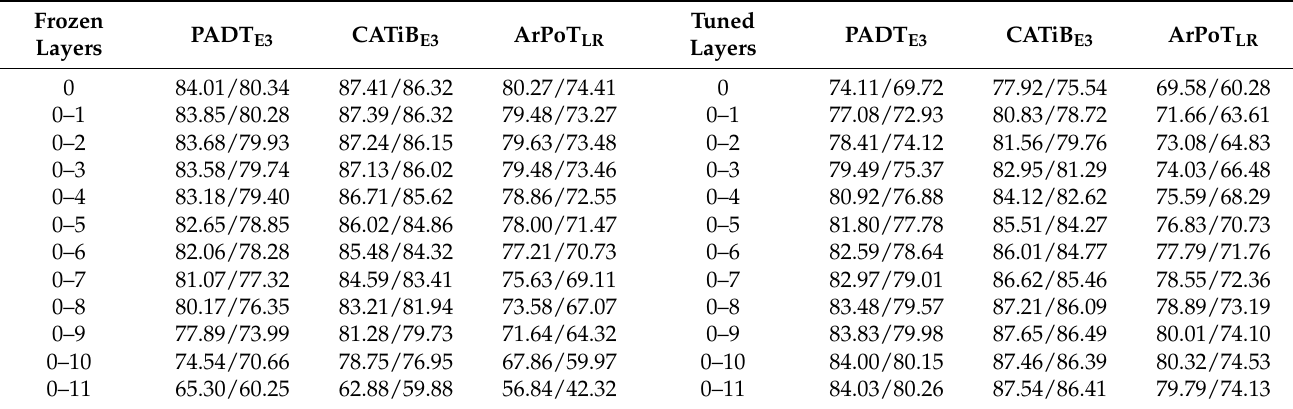
Table 14. UAS/LAS of partial freezing (PF) on test datasets.